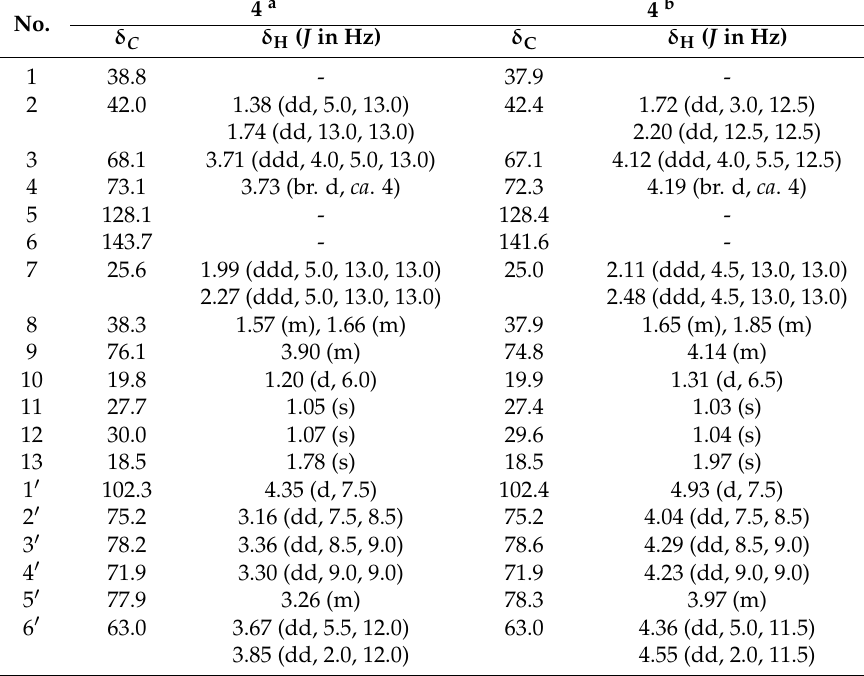
Table 4. The 1 H- and 13 C-NMR data of 4